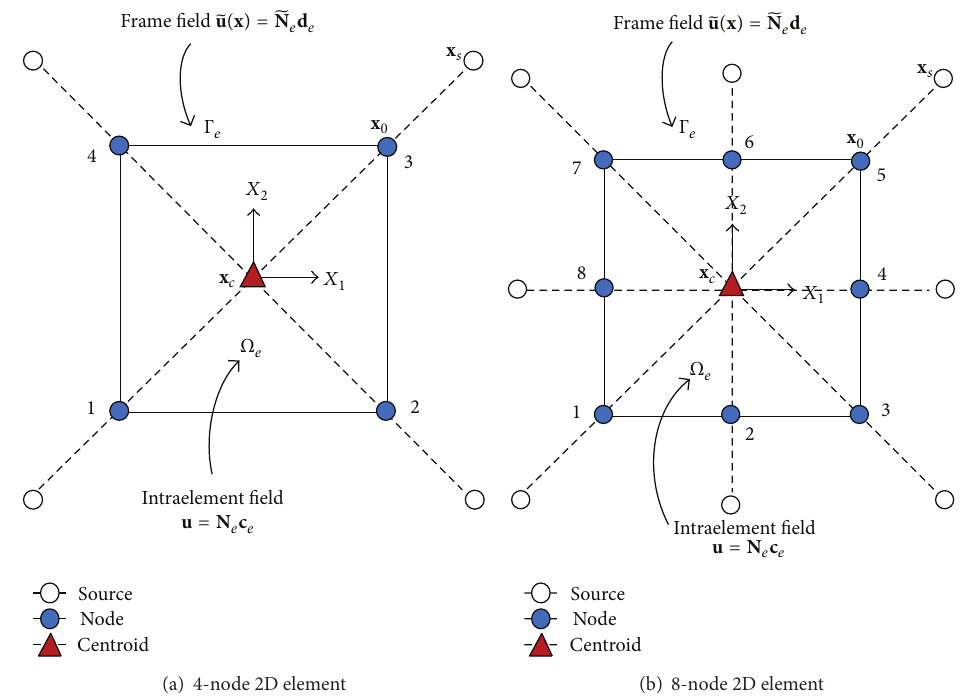
Figure 1: Intraelement field and frame field of a HFS-FEM element for 2D potential problems.